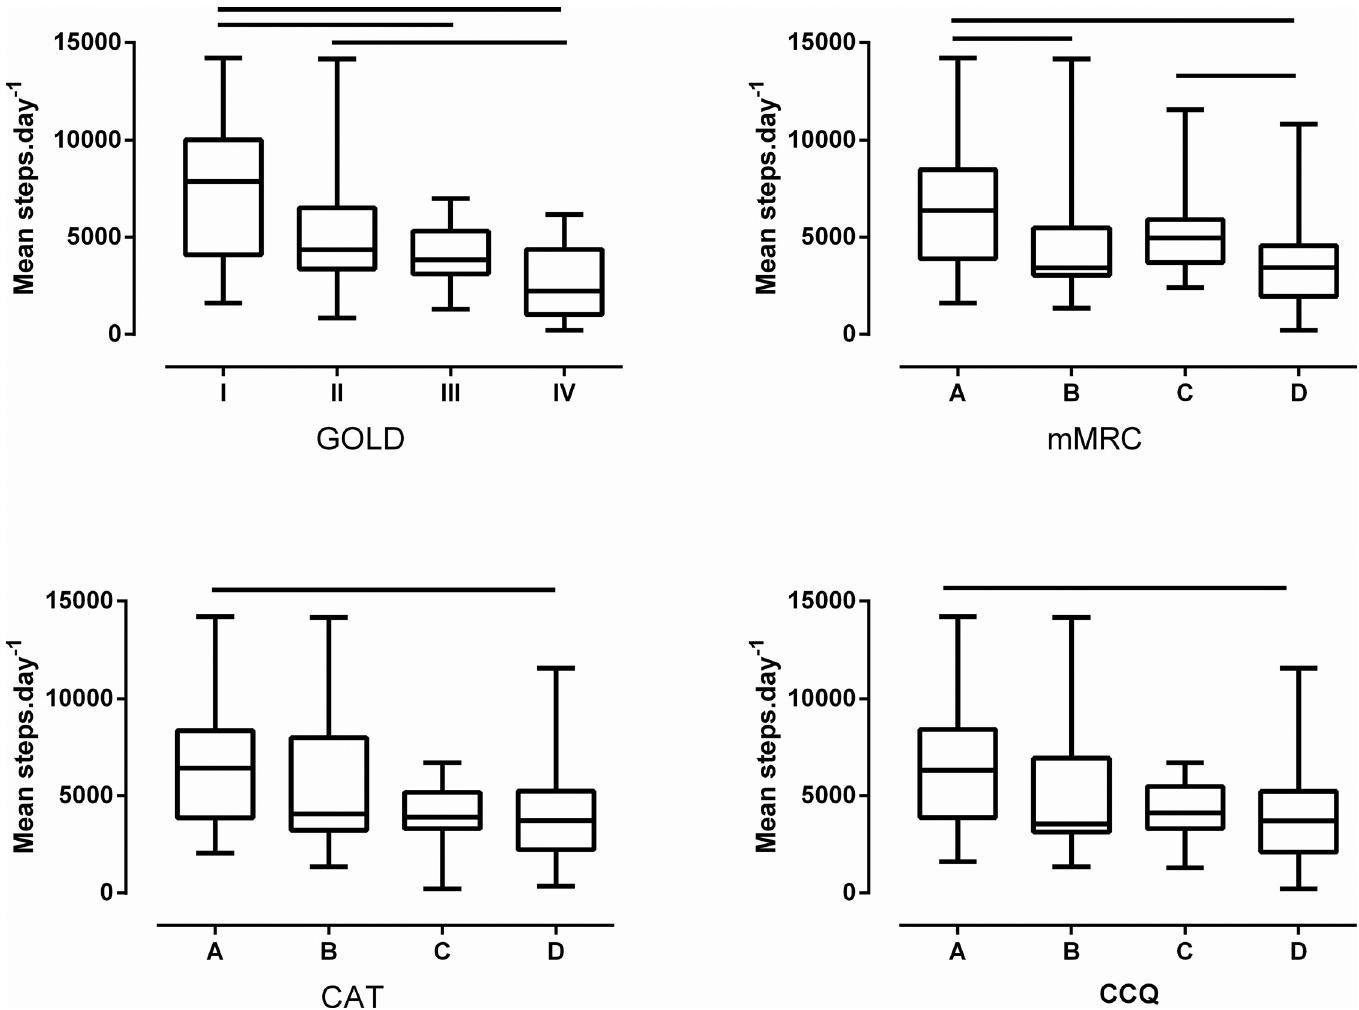
Fig 2. Physical activity across different GOLD classifications. GOLD = Spirometric GOLD classification; mMRC = combined assessment using mMRC; CAT = combined assessment using CAT; CCQ = combined assessment using CCQ; Significant differences (post hoc analysis) are indicated with a solid line.